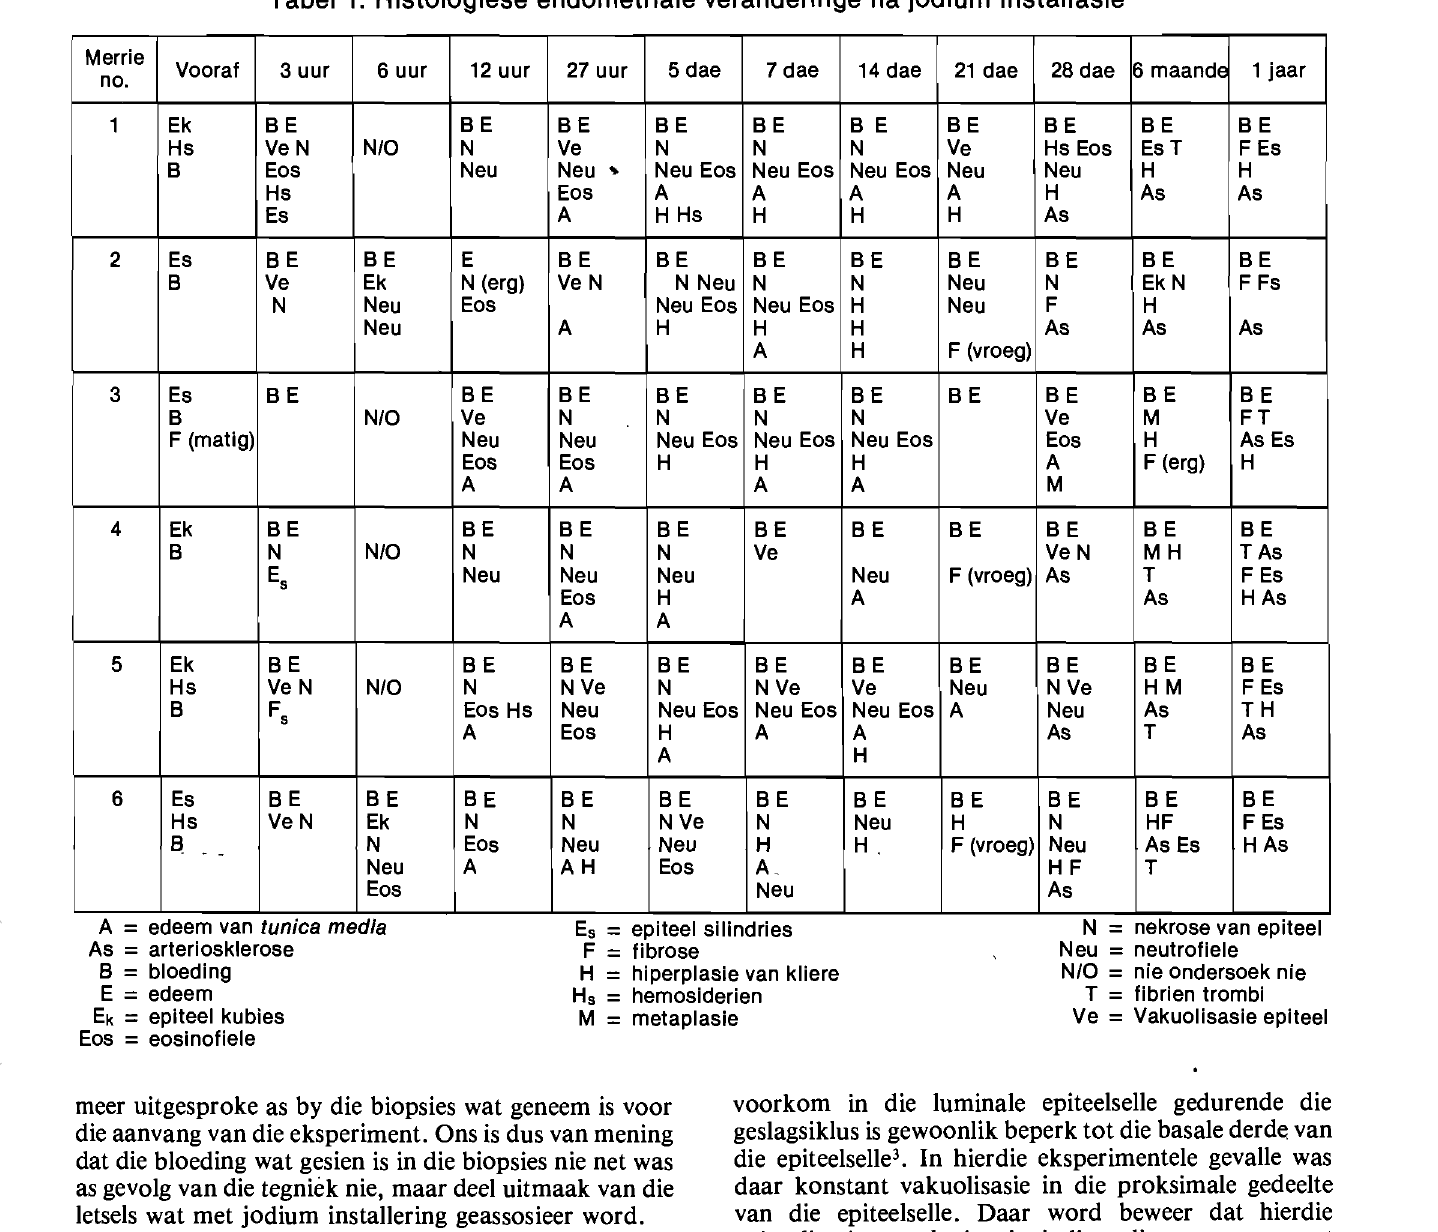
Tabel 1: Histologiese endometriale veranderinge na jodium